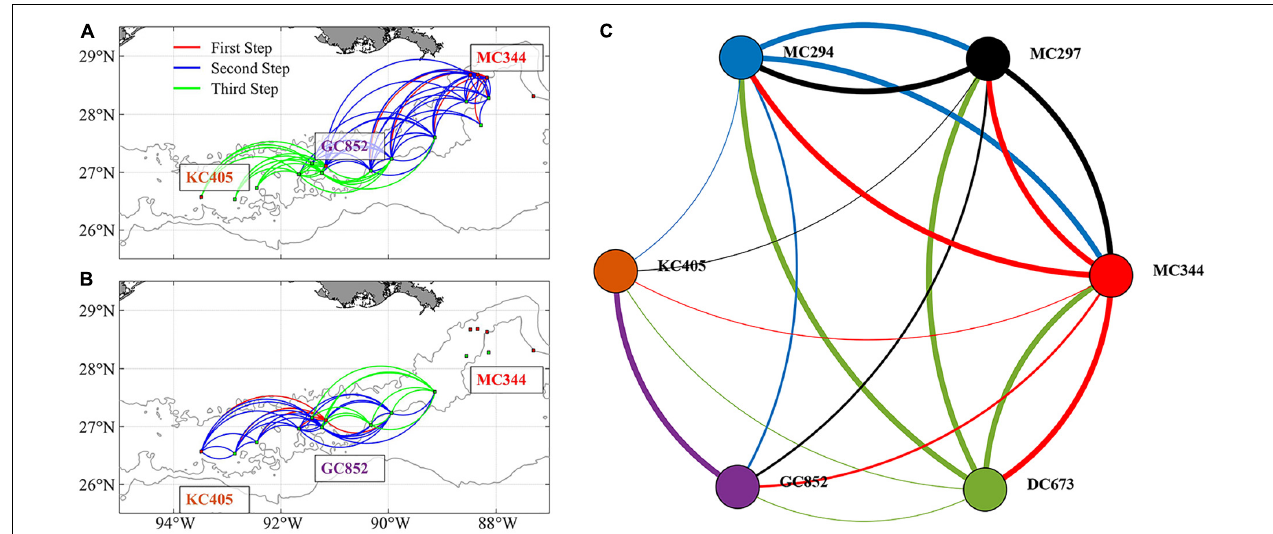
FIGURE 9 | Predicted 3D patterns of metapopulation connectivity considering the suitable intermediate sites. Connections found after three steps for larval particles released from sites MC344 (A) and GC852 (B) . Line colors in panels (A,B) indicate the step at which a connection between two sites was found. Connectivity network among the six sampled sites calculated after including intermediate sites (C) . Line colors in panel (C) indicate the source site for each connection. Linewidth in panel (C) indicates direct (thick lines, first step) or mediated connections (regular and thin lines, second and third steps,